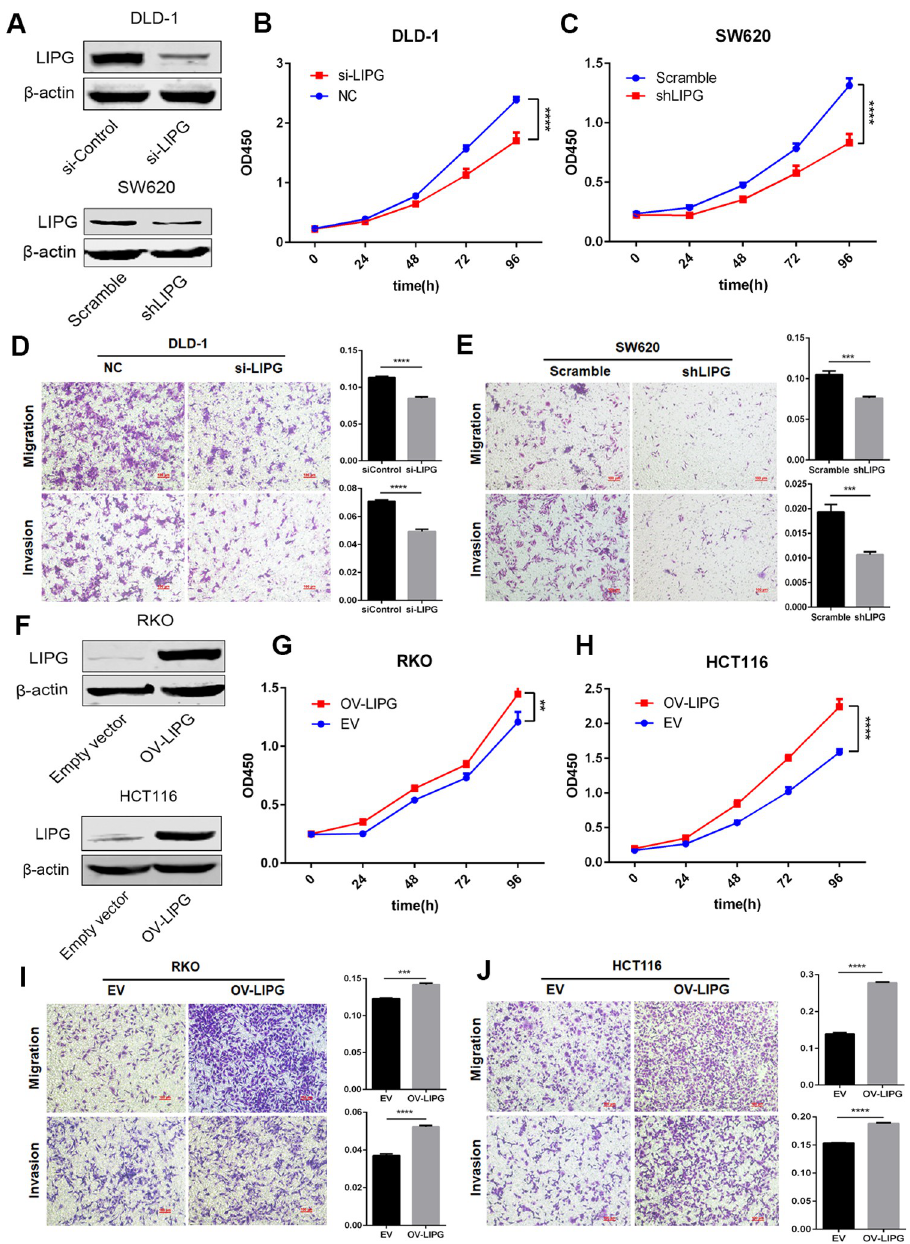
Fig 4. LIPG promotes CRC cell proliferation, migration and invasion in vitro. ( A ) Validation of LIPG knockdown efficiency by immunoblotting analysis in DLD-1 and SW620 cells. ( B, C ) The effect of LIPG knockdown on cell proliferation was measured by CCK-8 assay. ( D, E ) The effect of LIPG knockdown on cell migration and invasion capacity was measured by Transwell assay. ( F ) Validation of LIPG overexpression efficiency by immunoblotting analysis in RKO and HCT116 cells. ( G, H ) The effect of LIPG overexpression on cell proliferation was measured by CCK-8 assay. ( I, J ) The effect of LIPG overexpression on cell migration and invasion capacity was measured by Transwell assay. Error bars, SD. n = 3. Two-tailed Student’s t tests were used to assess statistical significance. �� P < 0.01, ��� P < 0.001, ���� P <